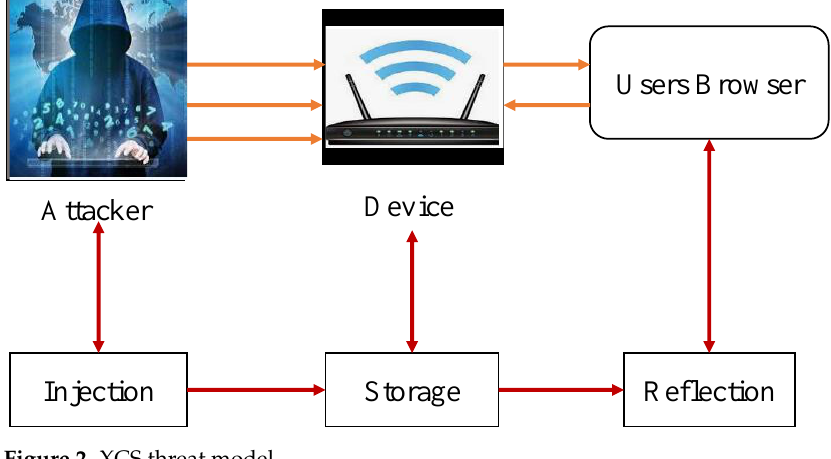
Figure 2. XCS threat